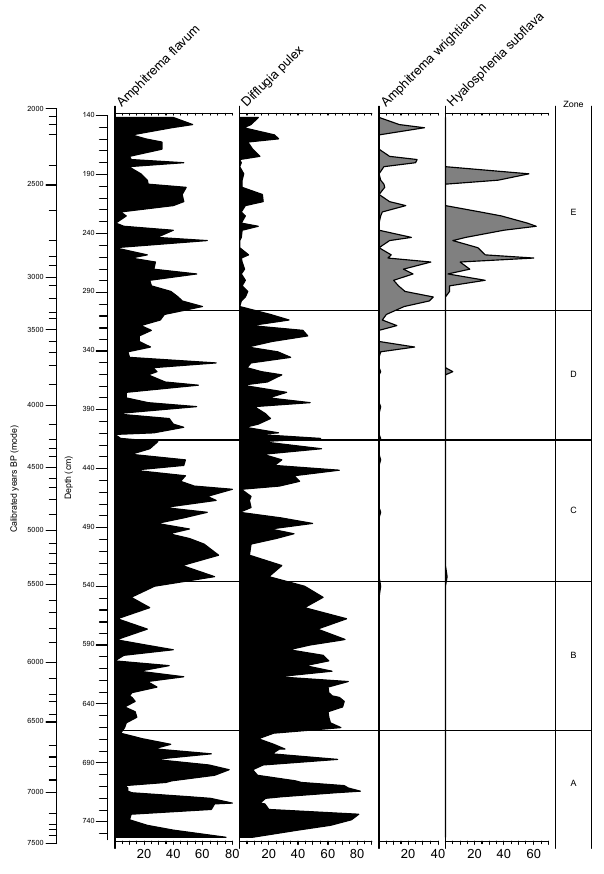
Fig. 6. Synthesised diagrams of dominant testate amoebae assem- blages (%) results from MIS-08-01b core.